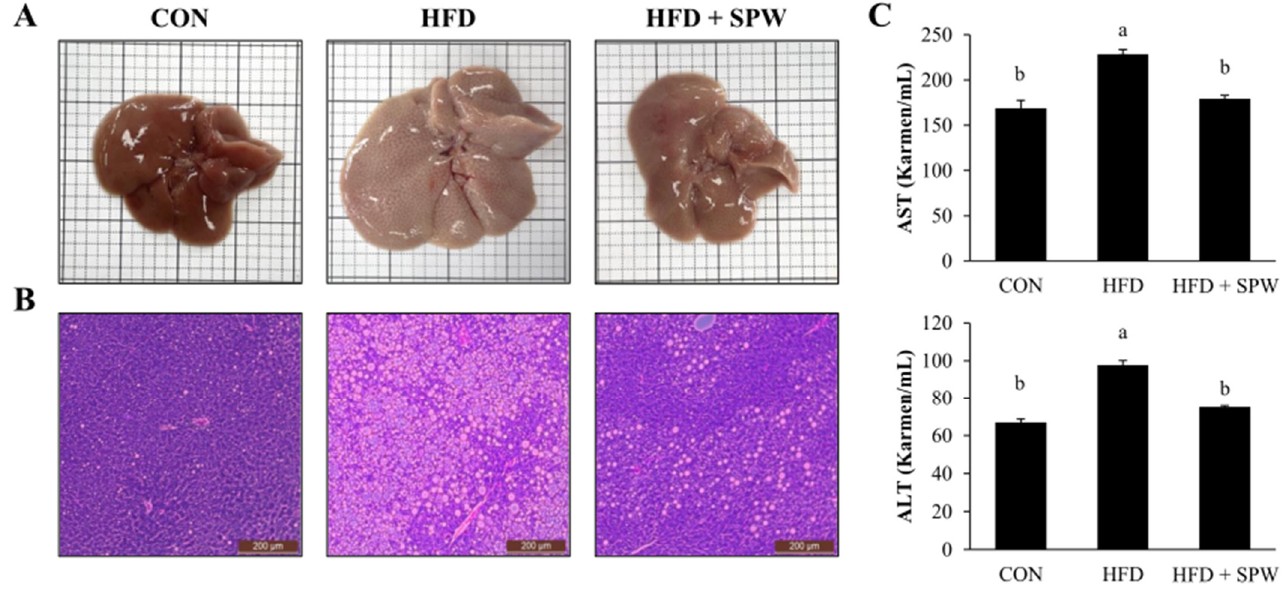
Figure 4. Salvia plebeia R. Br. water extract (SPW) intake ameliorated liver injury in HFD-induced NAFLD mice. ( A ) H&E stained liver tissues and ( B ) liver histology. ( C ) AST and ALT levels were measured in mice. Data represent mean ± SE ( n = 5 for each group). AST, aspartate transaminase; ALT, alanine transaminase; CON, control; HFD, high-fat diet; HFD + SPW, HFD + 200 mg/kg/day SPW; H&E, hematoxylin and eosin. The different letters above the bar indicate statistical difference based on Duncan’s multiple range test ( p < 0.05, a > b). Table 4. Biochemical parameters in HFD-induced NAFLD mice.